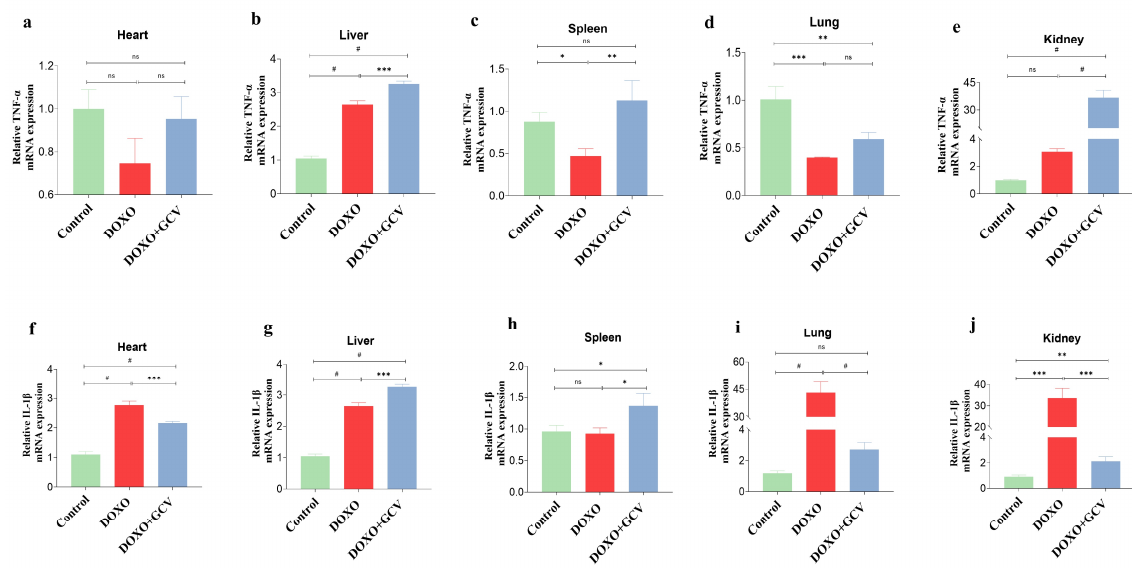
Figure 5. SASP factor changes in vital organs following GCV administration. ( a – e ) Representative TNF ‐α mRNA expression level of 5 vital organs in p21 ‐ 3MR mice from control/DOXO, and DOXO+GCV groups. ( f – j ) Representative IL ‐ 1 β mRNA expression level of 5 vital organs in p21 ‐ 3MR mice from control/DOXO, and DOXO+GCV groups. IL ‐ 1 β : interleukin ‐ 1 beta; TNF ‐α : tumor necrosis factor ‐ alpha. *, p < 0.1; **, p < 0.01; ***, p < 0.01; #, p < 0.0001; ns, no significance. One ‐ way ANOVA with Bonferroni correction for multiple